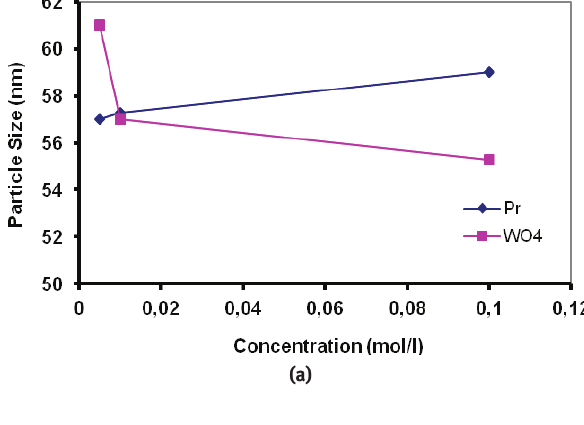
Figure 2: Average particle size of Pr eff ect of each variable at various levels.